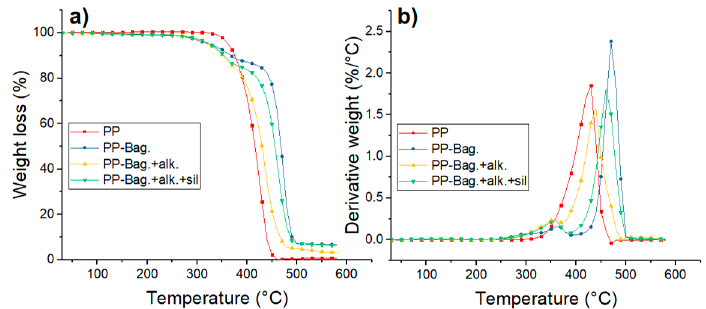
Figure 9. ( a ) TG and ( b ) DTG curves for fifth processing cycle PP and PP-Bagasse biocomposites. Table 4. Thermal degradation data of PP and PP-Bagasse